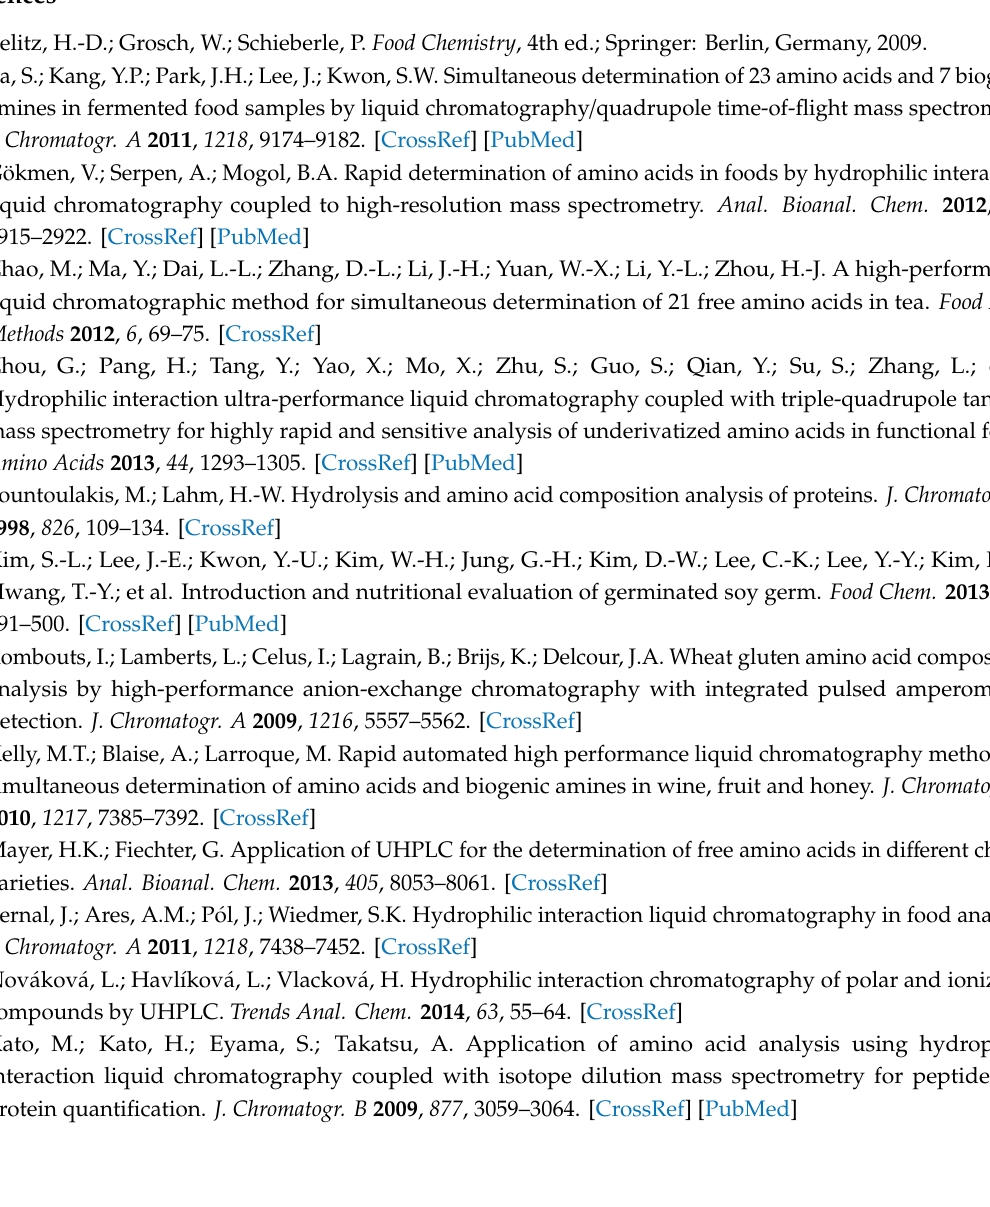
Table S1: Amino acids monoisotopic masses. Multiple Reaction Monitoring (MRM). Retention times (tR) and conditions in the mass spectrometer along with their respective molecular formulas, Table S2: Precision and trueness data for the analysis of AA in spiked B-90 bread wheat